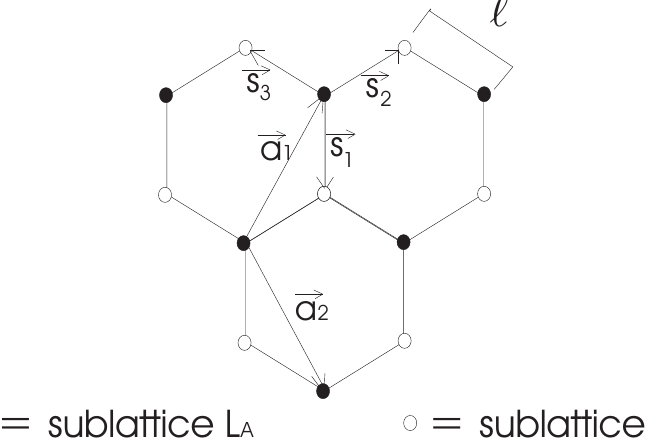
Figure 1. The honeycomb lattice of graphene, and its two triangular sublattices L A and L B . The choice of the basis vectors, ( (cid:126) a 1 , (cid:126) a 2 ) and ( (cid:126) s 1 , (cid:126) s 2 , (cid:126) s 3 ) , is, of course, not unique. Here we indicate the one used in [17]. Figure taken from